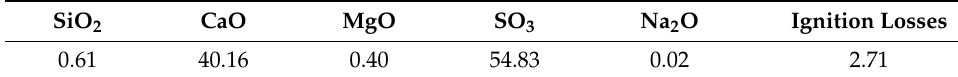
Table 4. Chemical composition of anhydrite, mass %.